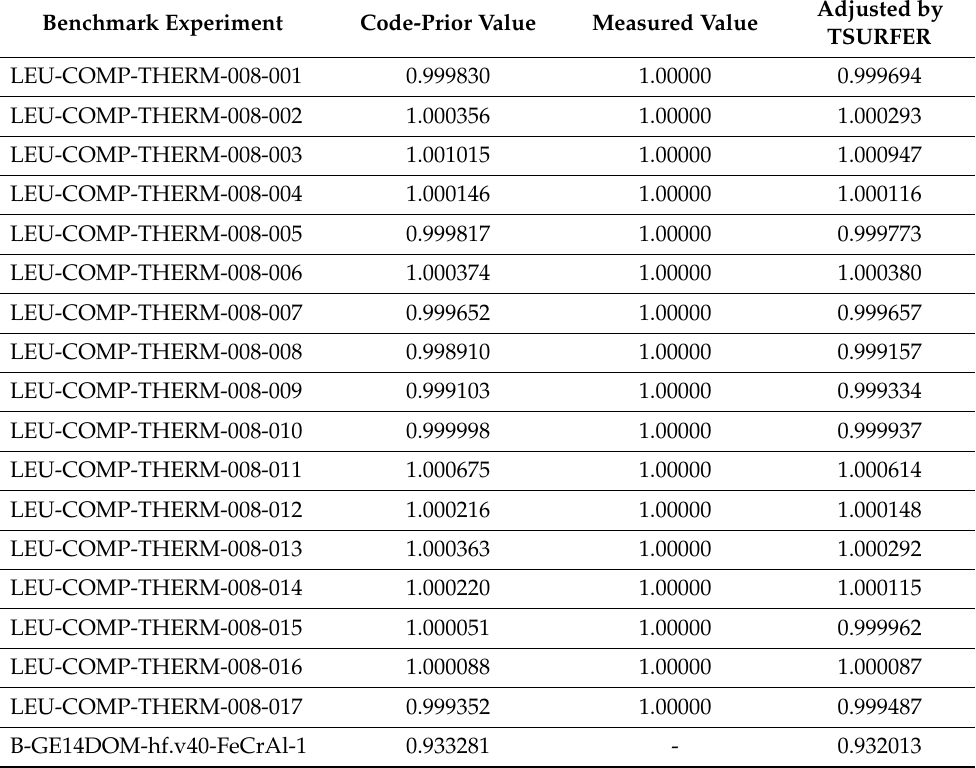
Table 1. TSURFER k eff